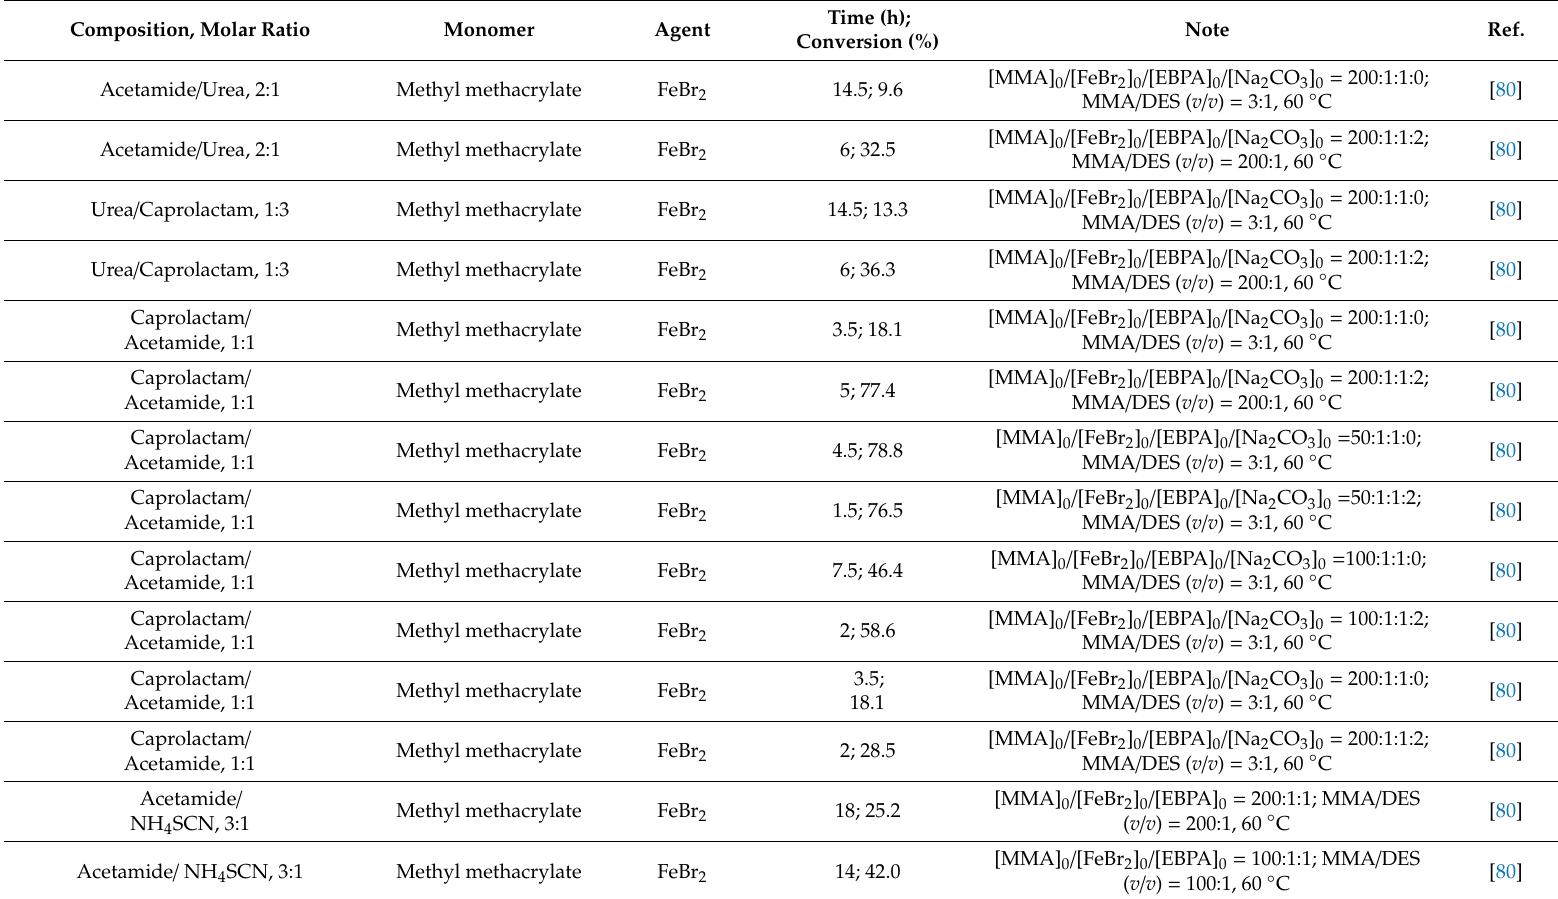
Table 8. Polymerization of monomers in